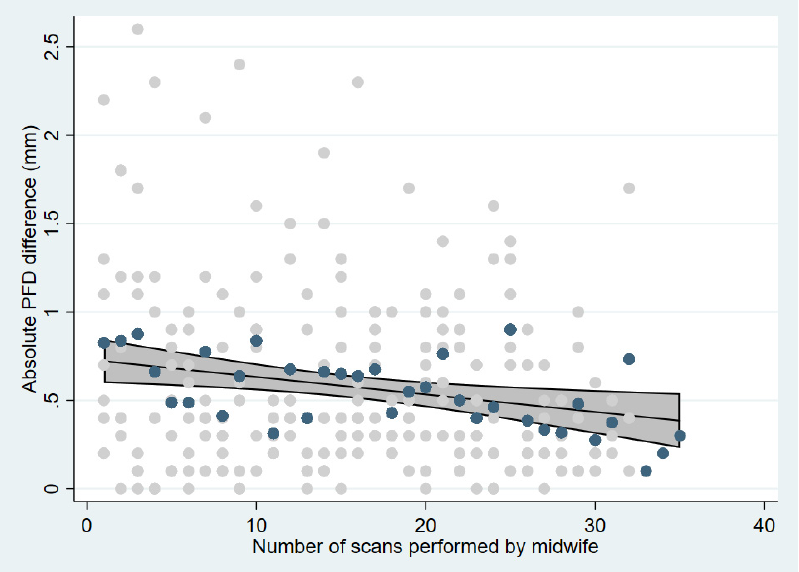
Figure 3. Scatter plot and fitted linear regression with 95% CI of absolute differences in PFD measurements between radiologists and midwives as a function of increasing scan experience. Light grey dots = individual values, blue dots = average values. PFD = Pubo-femoral distance. Table 3. Inter-rater ICCs of PFD measurements made by recruited midwives and supervising radi- ologists across four sessions of live scans. ICC = Inter-rater correlation coefficient .